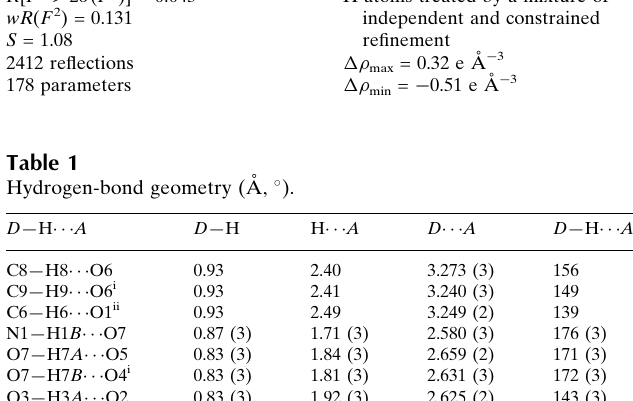
solution containing water as the salt,